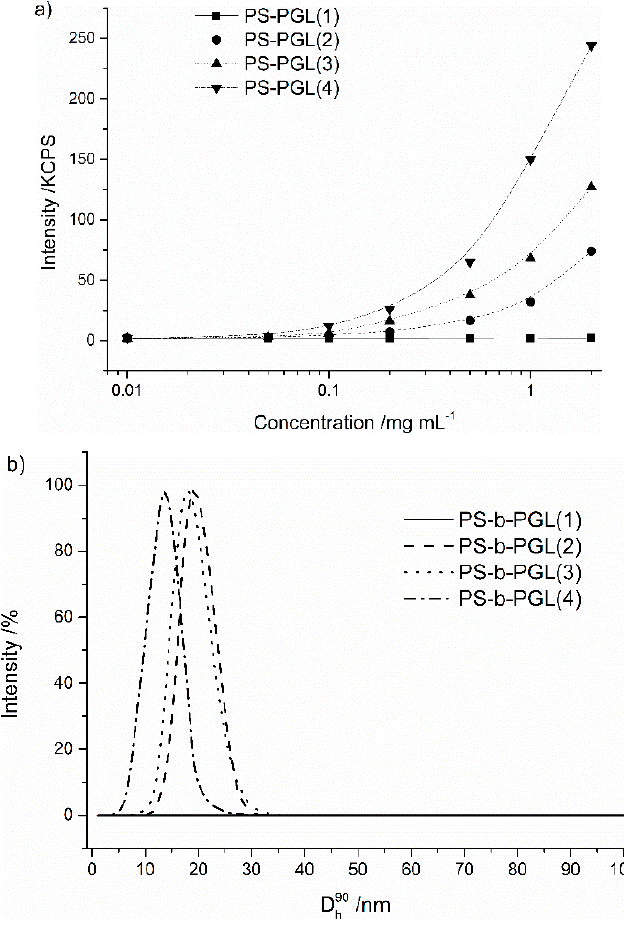
Figure 1. ( a ) The intensity of the scattered light as a function of the solution concentration for polystyrene- b -polyglycidol (PS- b -PGL), ( b ) Size distribution of PS- b -PGL(X) micelles formed above the critical micelle concentration (CMC) (at 1 mg/mL).